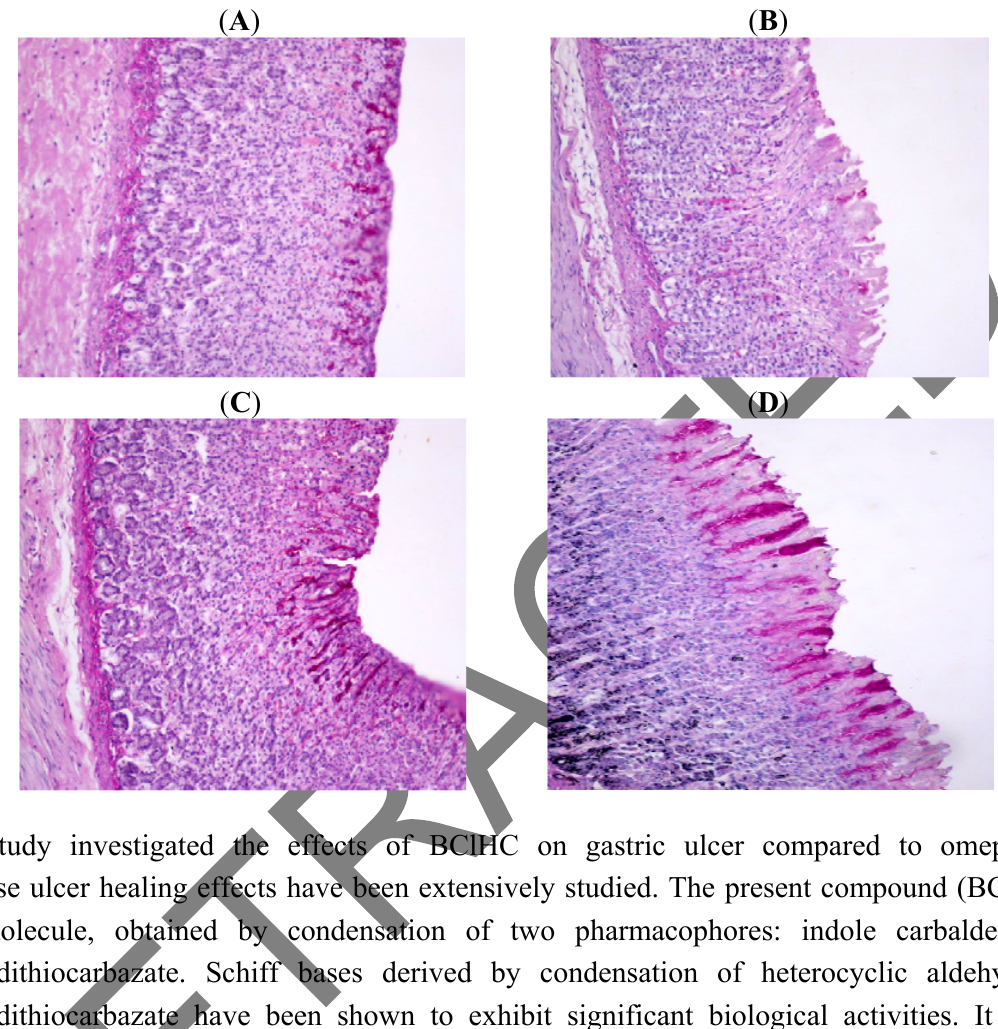
Figure 4. The effect of BClHC on gastric tissue glycoprotein-PAS staining in ethanol-induced gastric ulcer in rats (PAS stain 20×). ( A ) Normal control group; ( B ) Ulcer control group; ( C ) BClHC-treated group with 50 mg/kg; ( D ) BClHC-treated group with 400